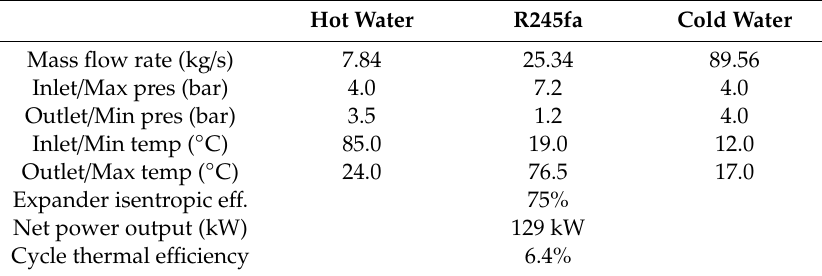
Table 2. Results from the cycle analysis at design point